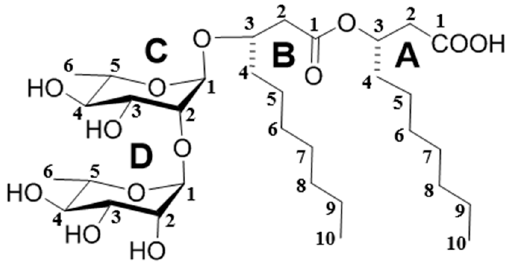
Figure 2. Structure of dirhamnolipid (Rha-Rha-C10-C10) identified from the pathogenic fungus Colletotrichum gloeosporioides BWH-1